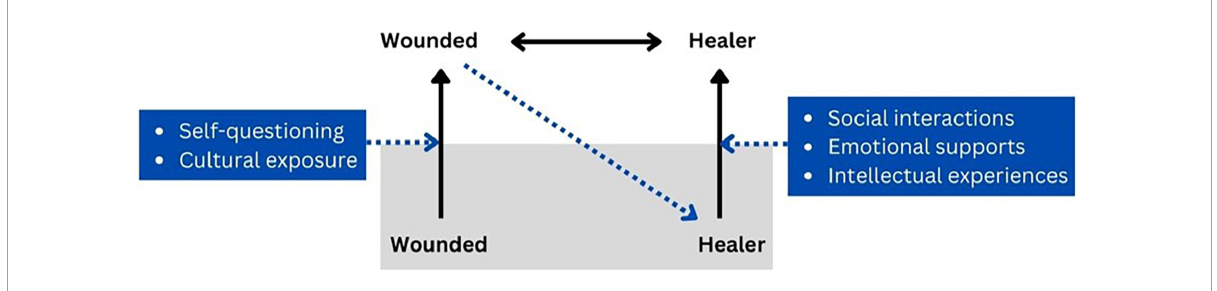
FIGURE2 Kadeem Bello’s being and becoming a wounded